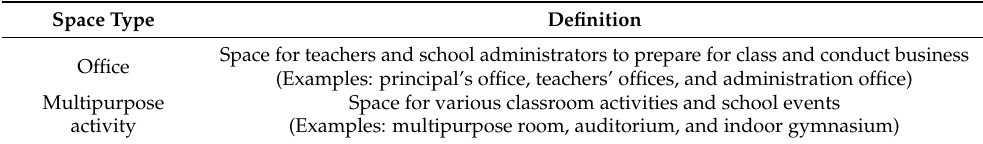
Table 1. Definitions of the functions of office and multipurpose activity spaces.